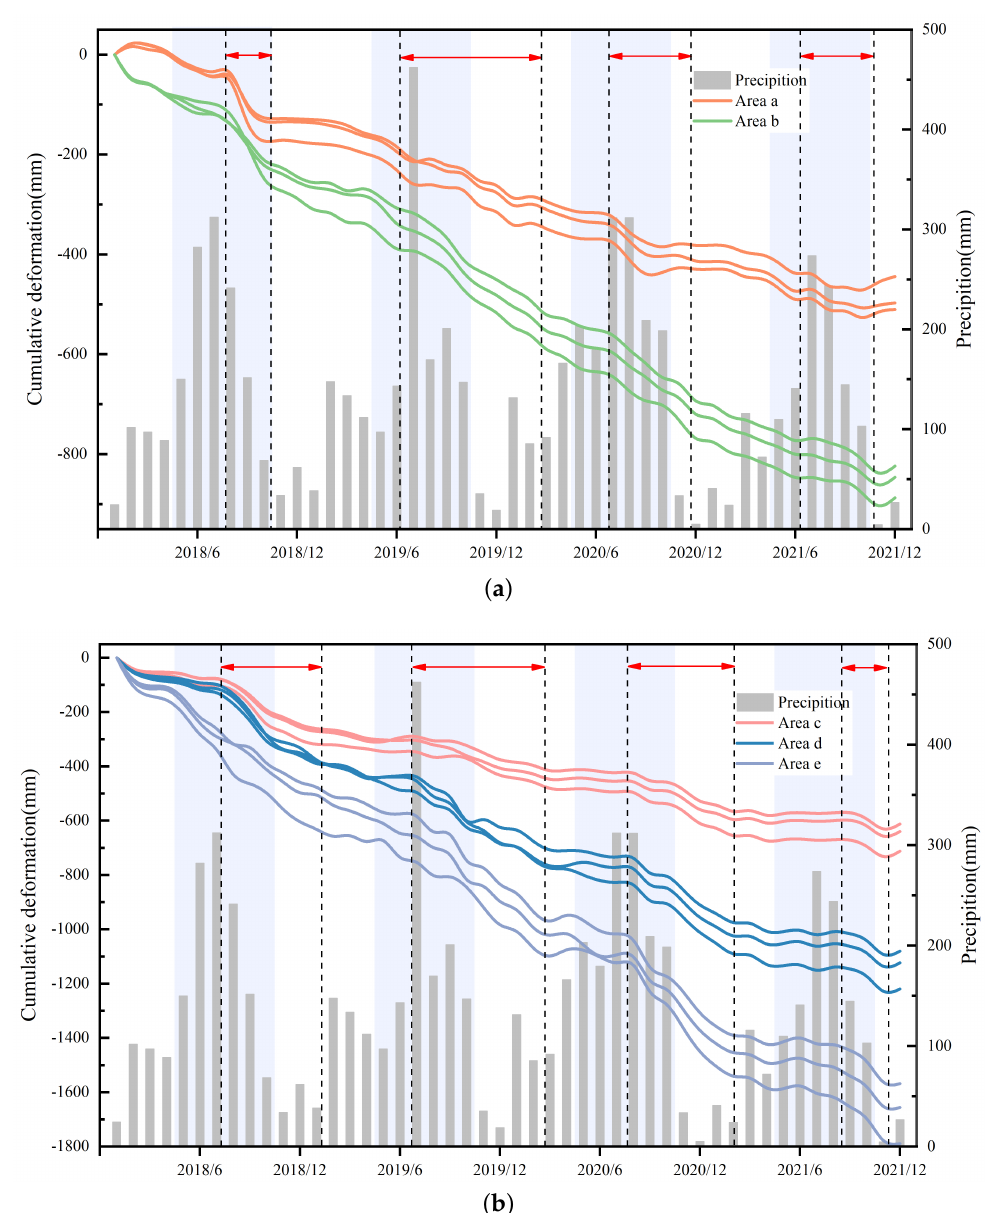
Figure 13. Time − series cumulative deformation of feature points. ( a ) The feature points in Area a, b (as shown in Figure 12f). ( b ) The feature points in Area c, d, e (as shown in Figure 12f). It can be seen from Figure 13 that the rainfall mainly takes place from May to October, and precipitation always reaches its peak in July, with the maximum average total rainfall in July 2019 reaching 462 mm. These rainfall season months are marked as mauve blocks, and the rest are wet season months. Time series analysis reveals that the displacement is corrected to the precipitation, and the rainfall variations have more impact on the middle and lower part of the landslide body than on the top body. The cumulative deformation curves of areas a and b have a slight trend of accelerated deformation after every wet season, as shown by the periods of time in the black dashed lines and red arrows in Figure 13a. The cumulative deformation curves of areas c, d, and e show segmented changes, and